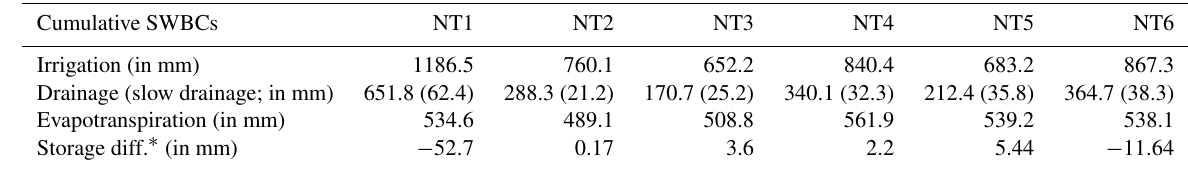
sponding ET values were very similar for all of the